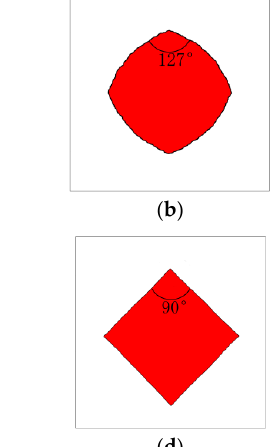
Figure 6. Simulation results for different values of